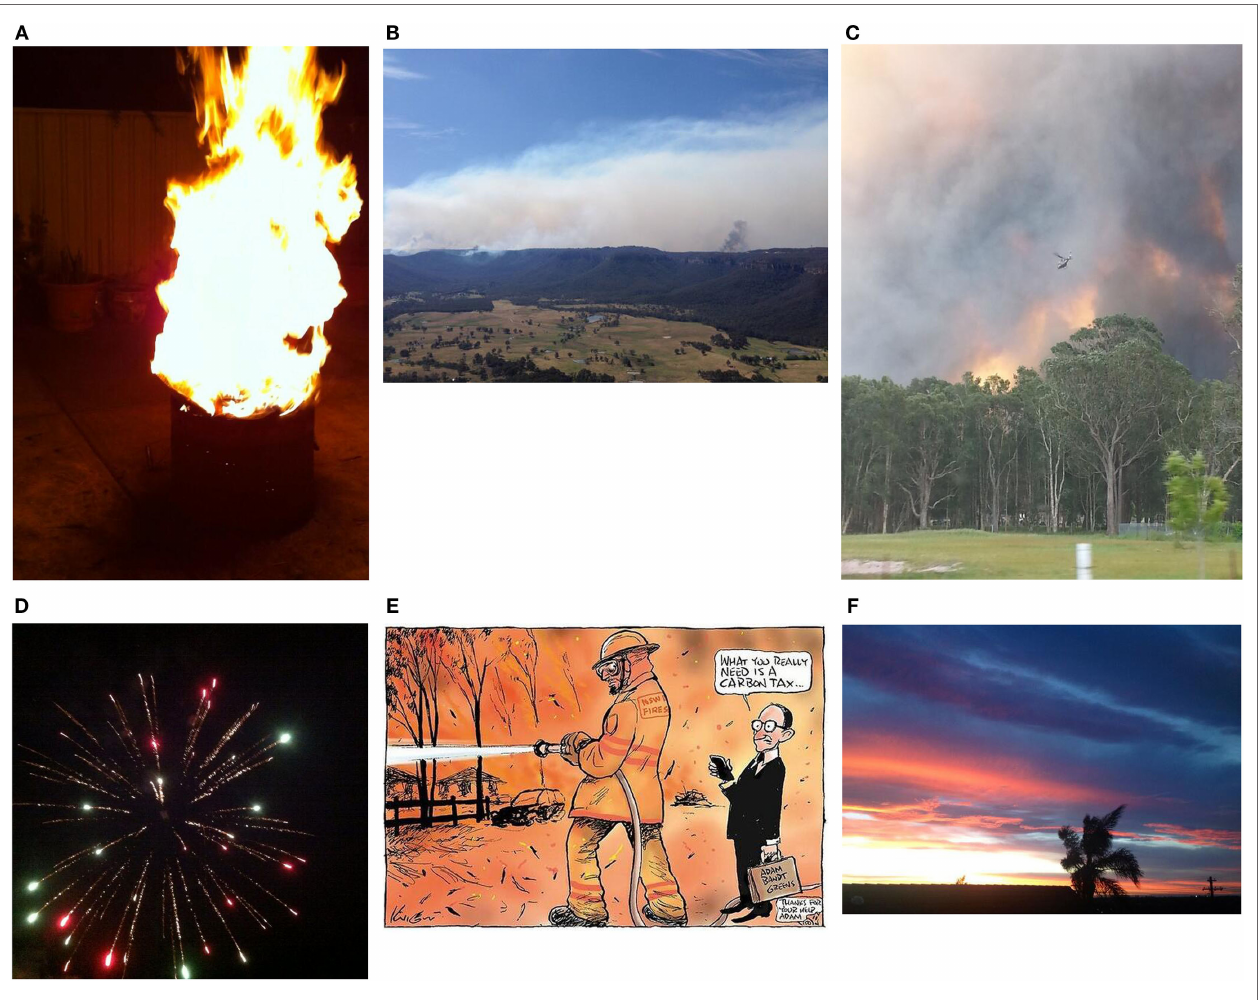
FIgURe 1 | Various images from our database compiled from fire-related tweets . Images (A–c) are manually grouped into a “fire” category, while (D–F) are “not-fire” images based on their potential usefulness to emergency services. The tweets for these images can be found at: http://twitter.com/NoobNelson/ statuses/385693129984061440; http://twitter.com/auxesis/statuses/391778476933410816; http://twitter.com/KAZMAC2/statuses/391772236866019330; http://twitter.com/FireworksSydney/statuses/391774856175312896; http://twitter.com/waxinggibberish/statuses/391807106220687360; and http://twitter.com/